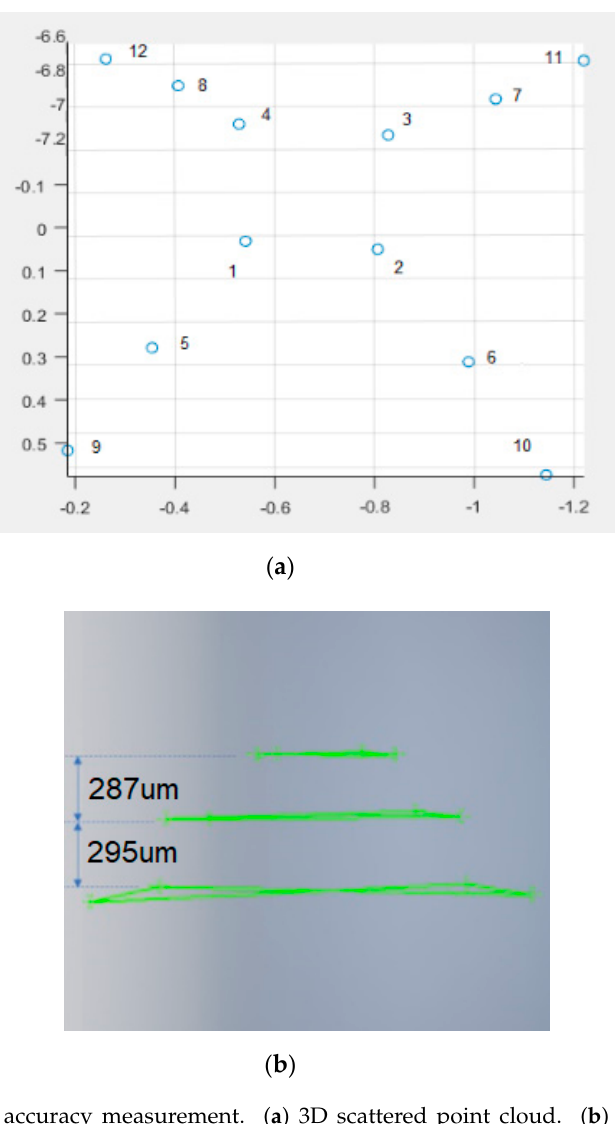
Figure 19. Depth accuracy measurement. ( a ) 3D scattered point cloud. ( b ) Depth measure by CAD modeling.